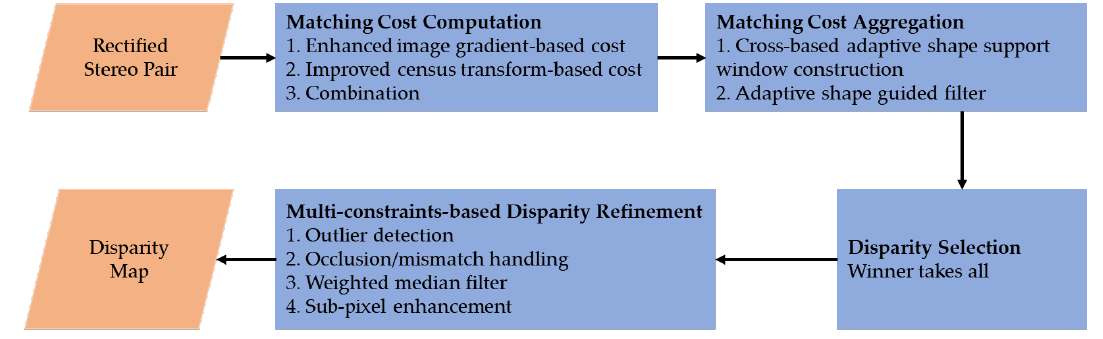
Figure 1. The workflow of the proposed method.